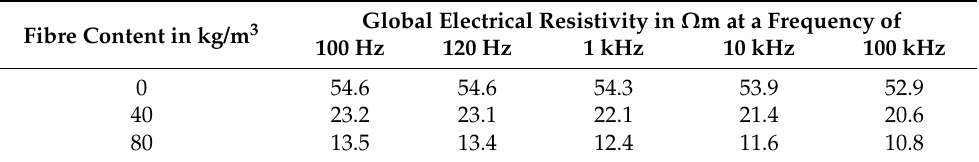
Table A51. Results of the resistivity measurements of the concrete mixture 32-60-300-00 after storage in synthetical pore solution for 91 days for the investigations of possible leaching effects.